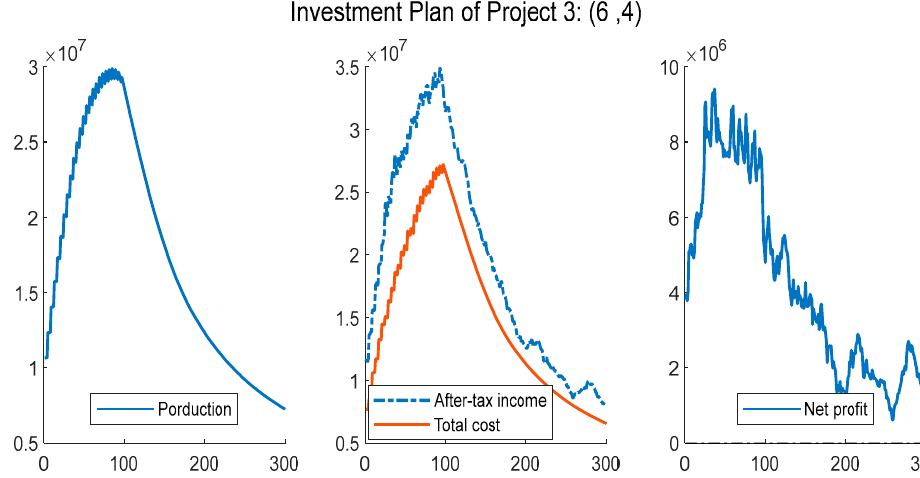
Figure A1. Production, income, cost, and net profit of project 3.